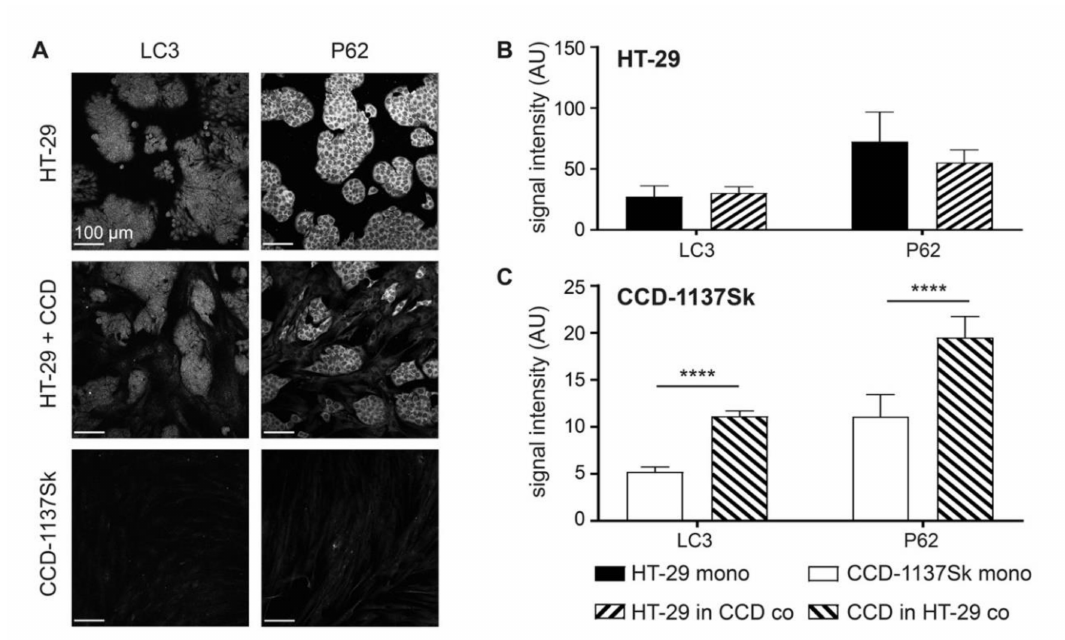
Figure 3. Fibroblasts in monolayer co-cultures of HT-29 and CCD-1137Sk display enhanced levels of autophagy markers. HT-29 and CCD-1137Sk cells were either seeded alone or in co-culture and grown to a sub-confluent state for four days. Then, cells were fixed and stained with DAPI as well as antibodies against LC3 and P62 as markers for nuclei and autophagy ( A–C ). ( A ) Representative confocal images of fluorescence staining for markers and cultures as indicated. ( B ) and ( C ) Graphs showing quantitative analysis of fluorescence intensity values for markers and cell type as